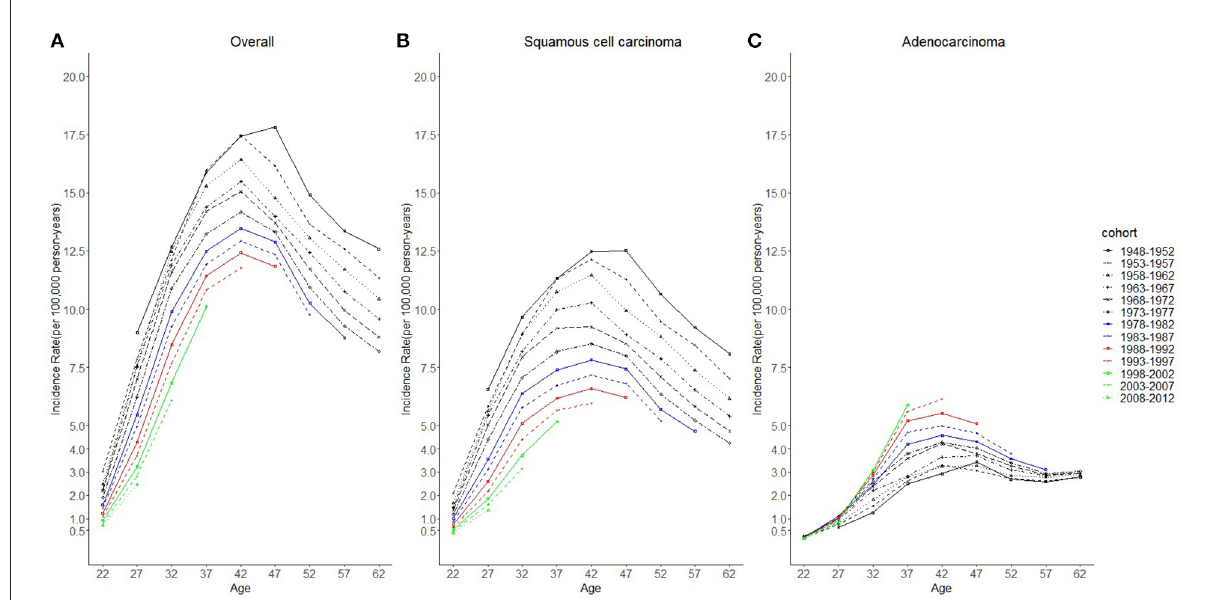
FIGURE9 Predicted age trends in cervical cancer incidence rates among females in 1948–1997 birth cohorts by cohort and histology, United States. (A) Predicted age trends of all histopathologic subtypes combined. (B) Predicted age trends of squamous cell carcinoma (SCC). (C) Predicted age trends of adenocarcinoma (AC). All data are expressed as the rate per